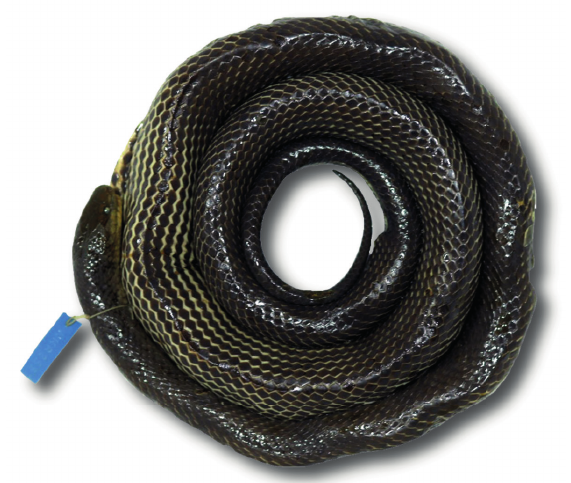
(AJ03/44): juvenile male, collected on March 2003. Figure 1. Dorsal view of Oxyrhopus emberti (MNKR 2551,